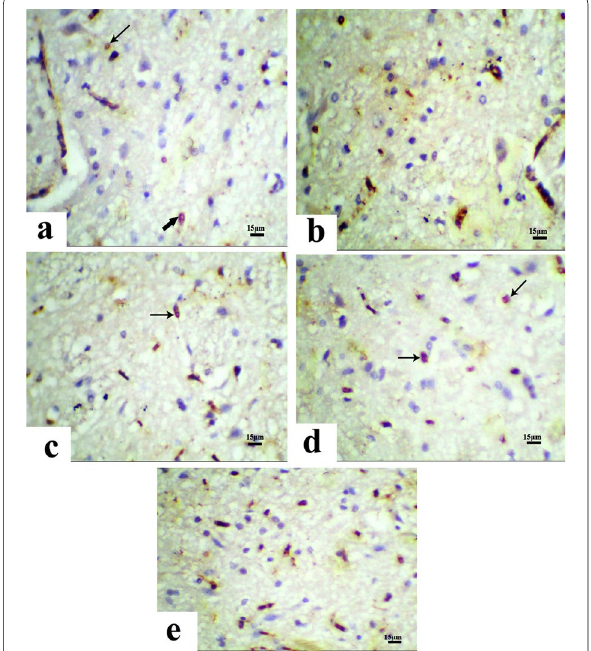
Fig. 11 Photomicrographs obtained from sections of cerebral cortex a : of control rat showing PCNA expression in few nuclei of granule cell (thin arrow) and pyramidal cells (thick arrow). b : obtained from ALA-treated animal showing normal PCNA expression. c : of reserpine-treated rat showing decrease in number of nuclei with positive PCNA expression (arrow). d : obtained from animal treated with reserpine and paroxetine showing positive PCNA expression in considerable number of nuclei (arrows). e : obtained from rat treated with ALA and paroxetine showing nearly normal PCNA expression appeared in some nuclei